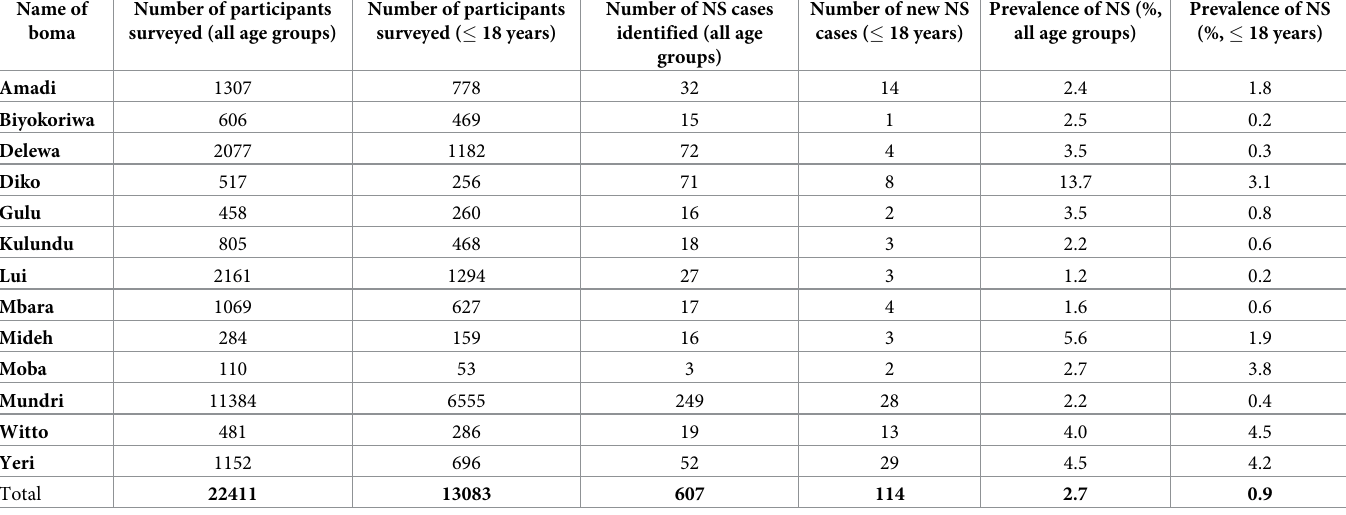
Table 2. Prevalence of nodding syndrome by Boma in Mundri East and West Counties, South Sudan. Name of Number of participants boma surveyed (all age